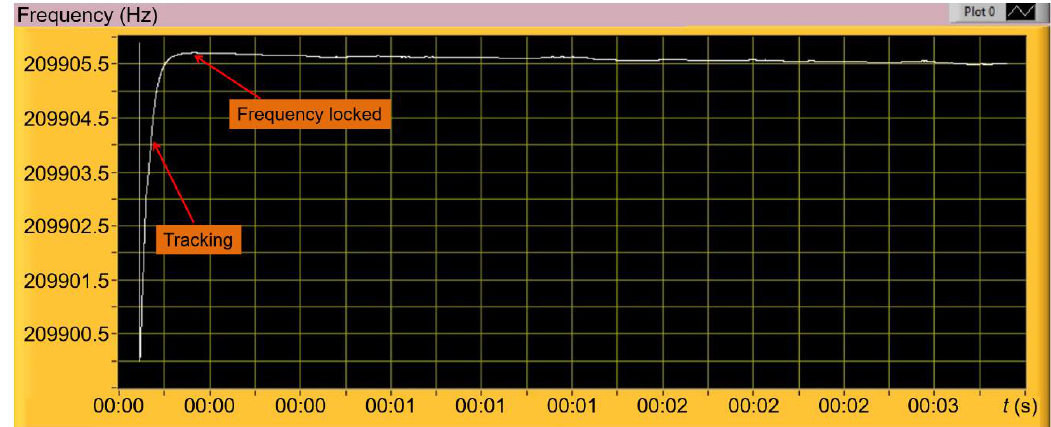
Figure 4. A developed LabVIEW-based user interface to track and lock the resonance frequency of the EtPCS. The selected reference parameters are included for keeping the optimized phase-locking state during resonance tracking.